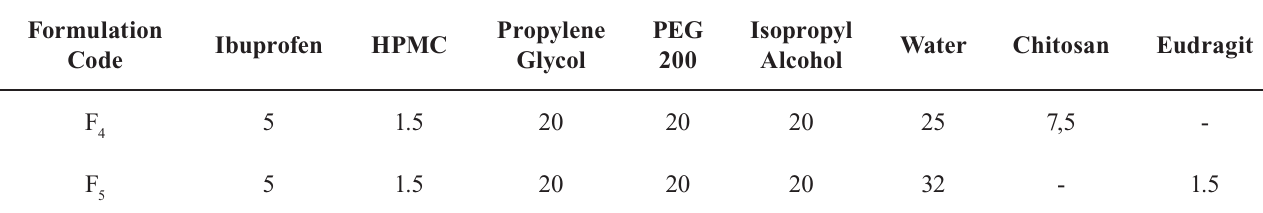
TABLE II - Topical patch composition % (w/w) with addition of adhesive polymer